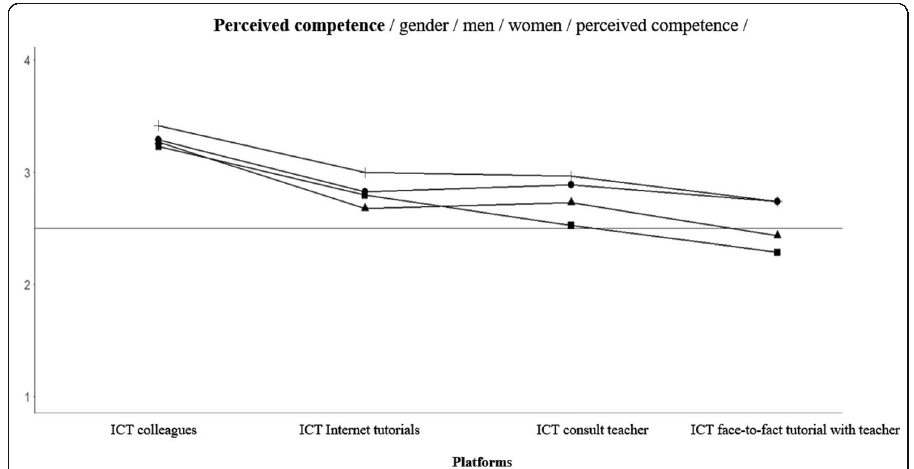
Fig. 5 Perceived interpersonal competence by